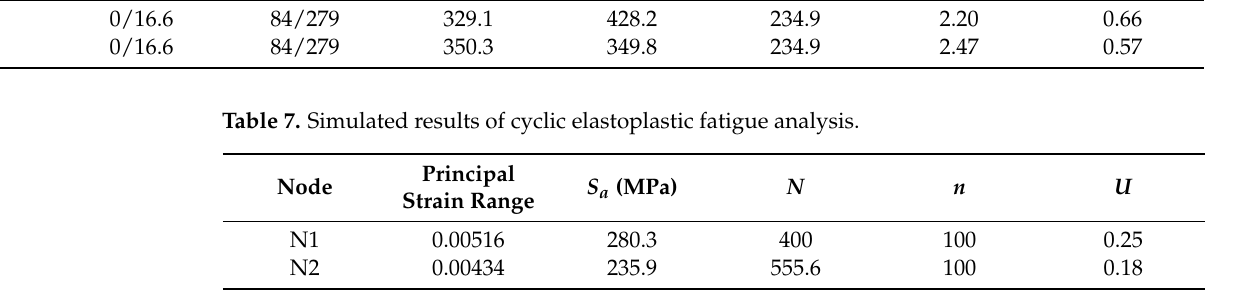
Table 6. Simulated results by simplified elastoplastic analysis.